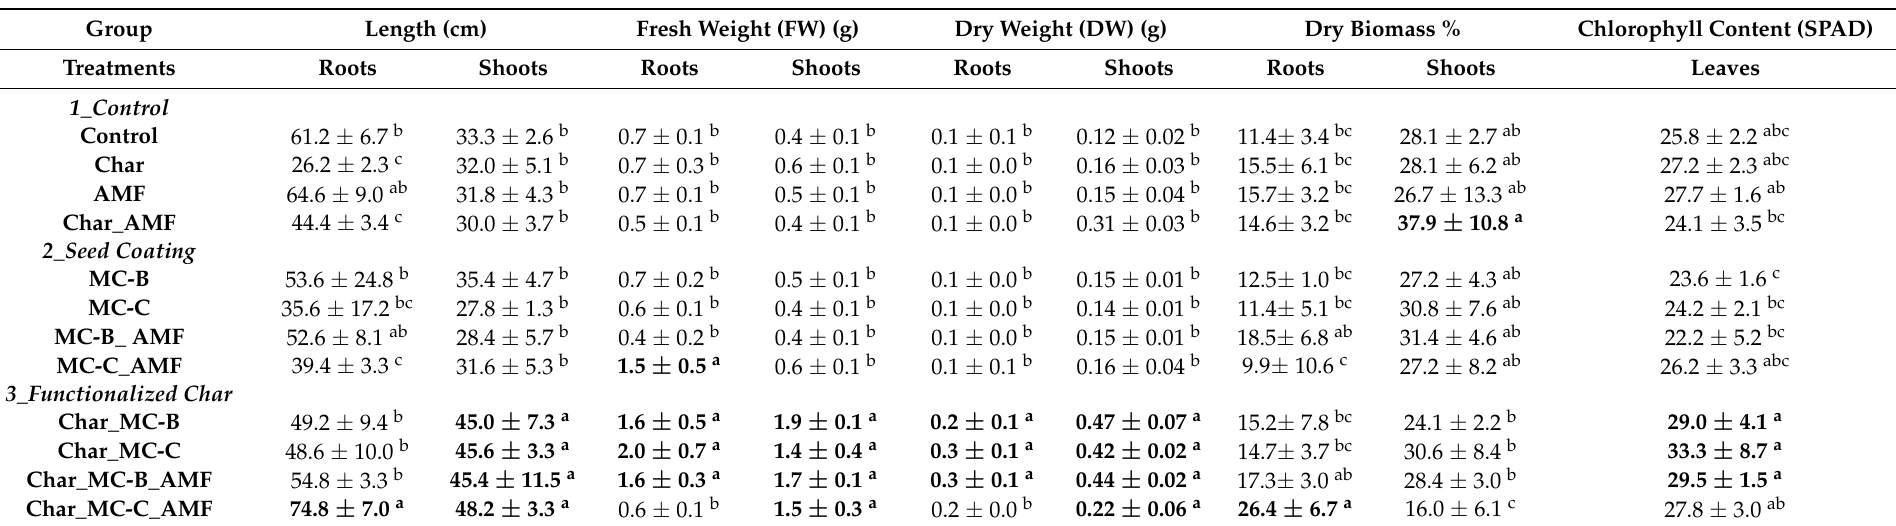
Table 1. Measurements of the physiological parameters analyzed for wheat shoots and roots under the different treatments. For each trait, the mean value and standard deviation are reported.